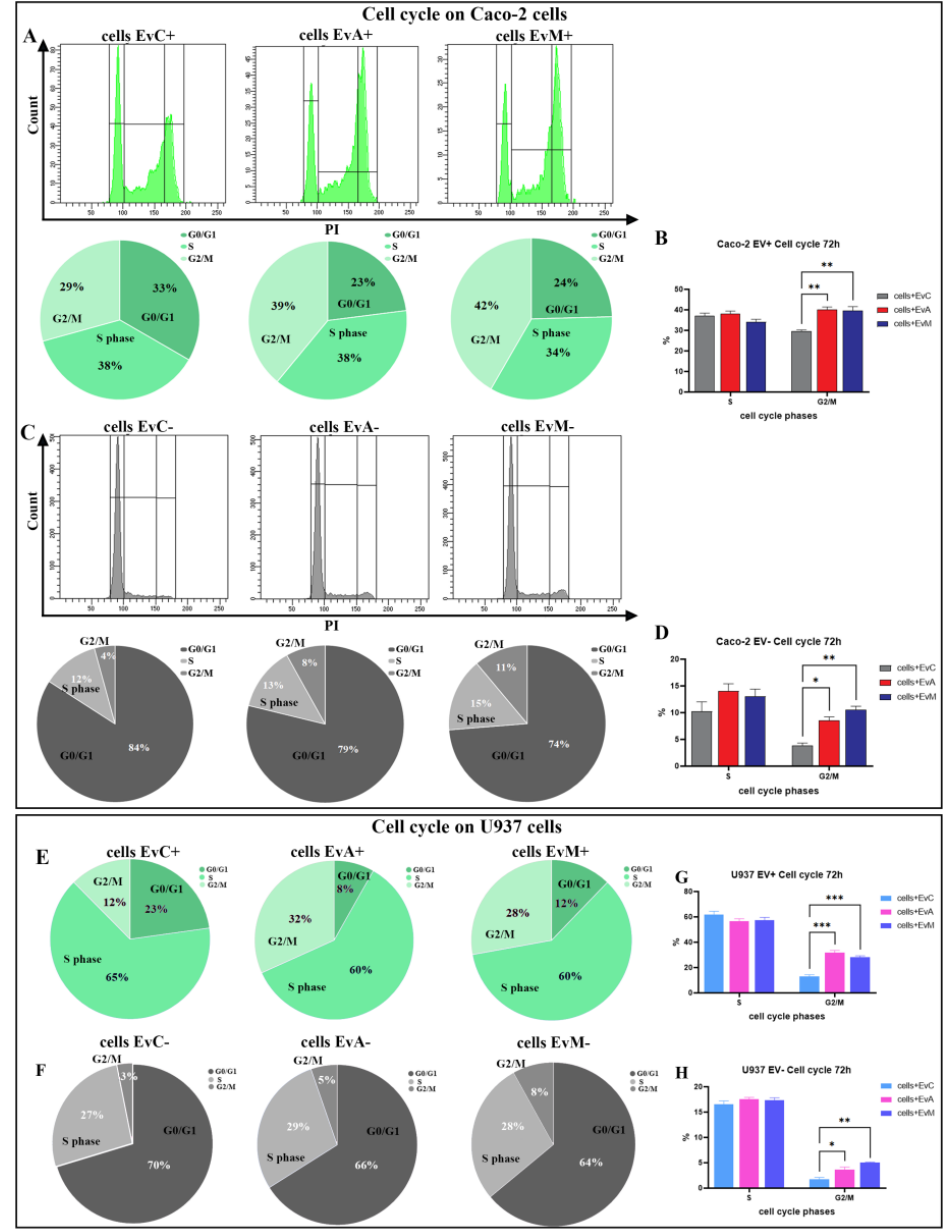
Figure 8. ( A ) Cytometric histograms (above) and pie chart (below) for the cell cycle distribution of Caco-2 cells with detected EvC+, cells with detected EvA+, cells with detected EvM+. ( B ) Statistical histogram of the S and G2/M phases of cell cycle calculated in cytometry via PI staining at 72 h in Caco-2 cells with detected EV+. ( C ) Cytometric histograms (above) and pie chart (below) for the cell cycle distribution of Caco-2 cells with undetected EvC, cells with undetected EvA, cells with undetected EvM. ( D ) Statistical histogram of the S and G2/M phases of cell cycle calculated by flow cytometry via PI staining at 72 h in Caco-2 cells with undetected PKH67 EV (EV − ). ( E ) Pie chart of the cell cycle distribution on U937 cells with detected EV+. ( F ) Statistical histogram of the S and G2/M phases of the cell cycle of cells with detected EV calculated in cytometry via PI staining at 72 h. ( G ) Pie chart of the cell cycle distribution on U937 cells with undetected EV − . ( H ) Statistical histogram of the S and G2/M phases of the cell cycle of cells with undetected EV − calculated in cytometry via PI staining at 72 h. Two-way ANOVA with Bonferroni’s multiple comparison test. The asterisk denotes a statistically significant difference (* = p < 0.05, ** = p < 0.01, *** = p <